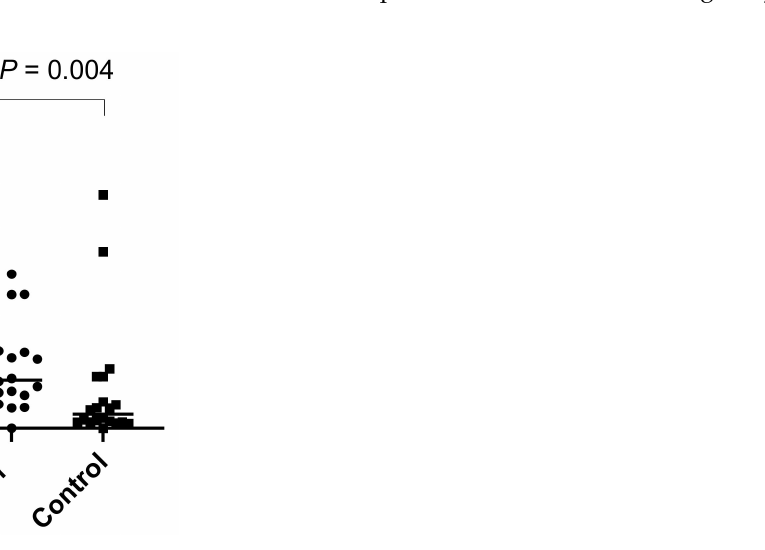
Figure 6. Alliin and associated metabolites in urine of participants consuming alliin supplements or not (control). p -values are from Mann–Whitney